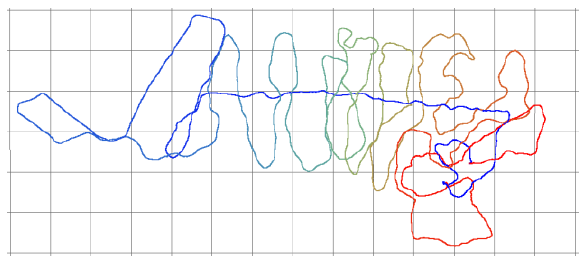
Figure 11. Measurement